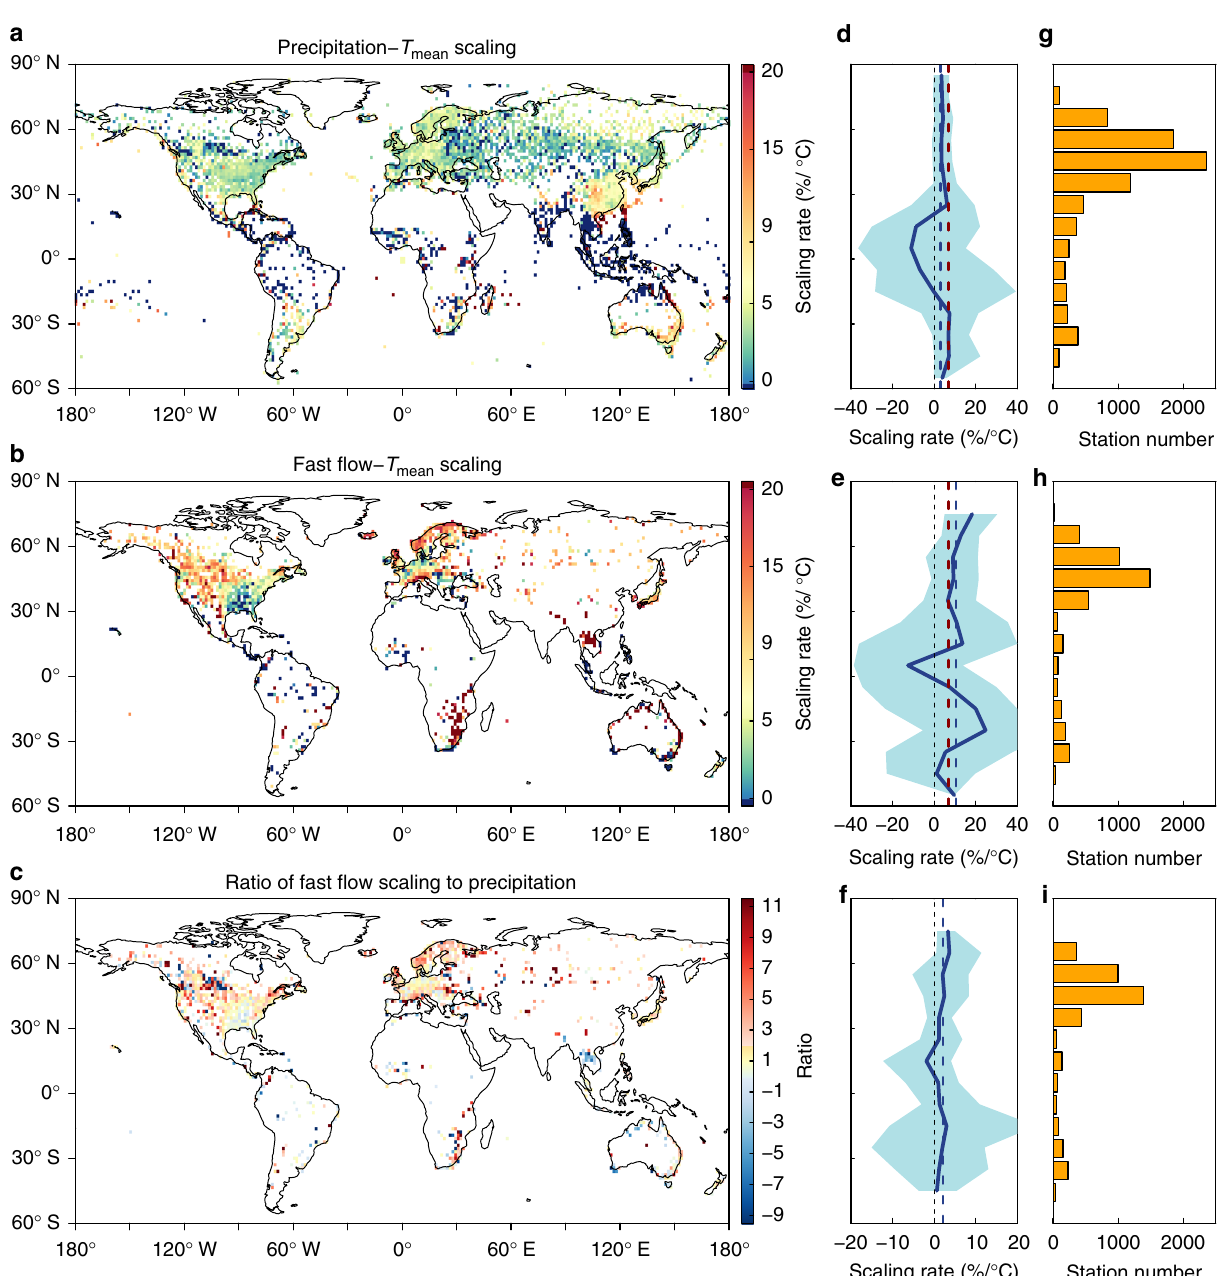
Fig. 3 Global scaling results for 99th percentile precipitation and fast fl ow extremes with local temperature. a Scaling results of precipitation extremes with T fl ow extremes with T fl ow to precipitation scaling with T – f Zonal results based on precipitation mean . b Scaling results of fast mean . c Ratio of fast mean . d scaling, fast fl ow scaling and ratio, respectively. g – i Used stations for precipitation scaling, fast fl ow scaling and ratio analysis, respectively. Solid blue lines indicate the median scaling rate or ratio in each latitude band, and the shading shows the associated 90% con fi dence intervals. Dashed blue lines indicate the global average values, and dashed red lines in d , e indicate C – C